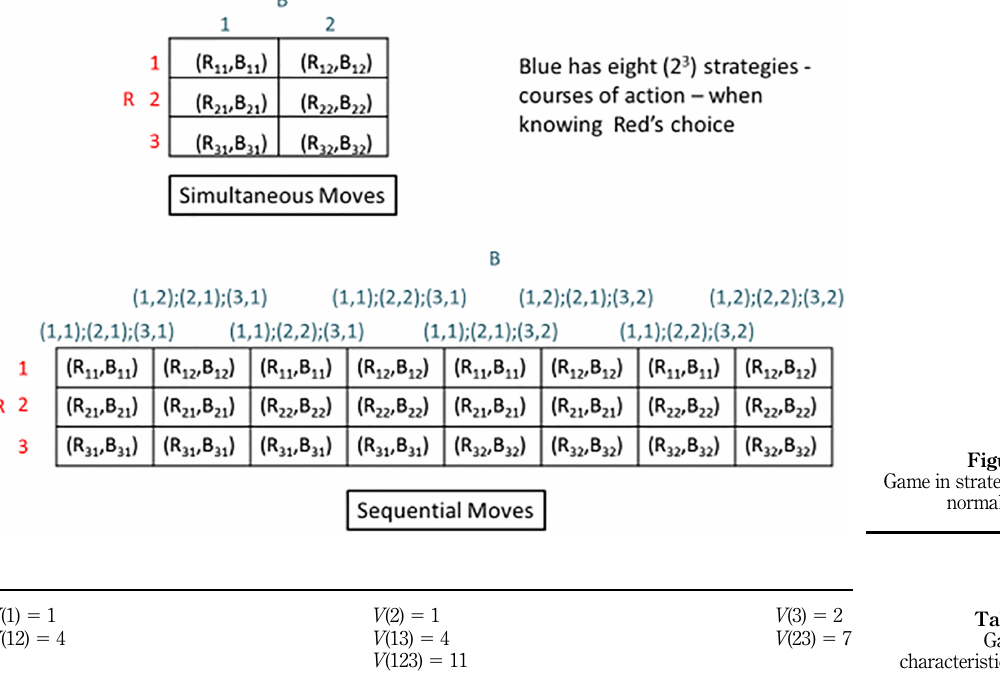
Figure 2. Game in strategic, or normal,